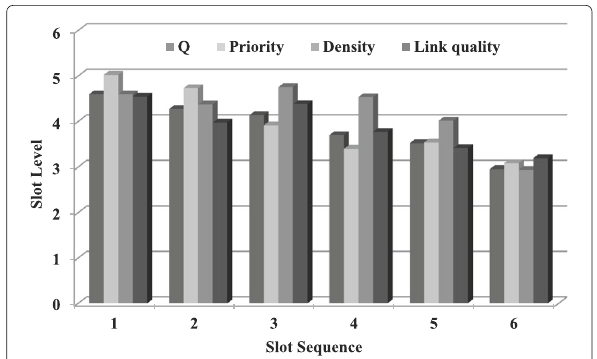
Fig. 12 Transmission factor and cross-layer information in different